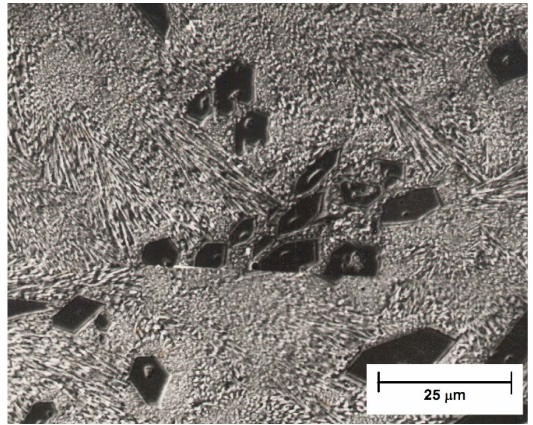
Figure 19. Carbides in ledeburitic